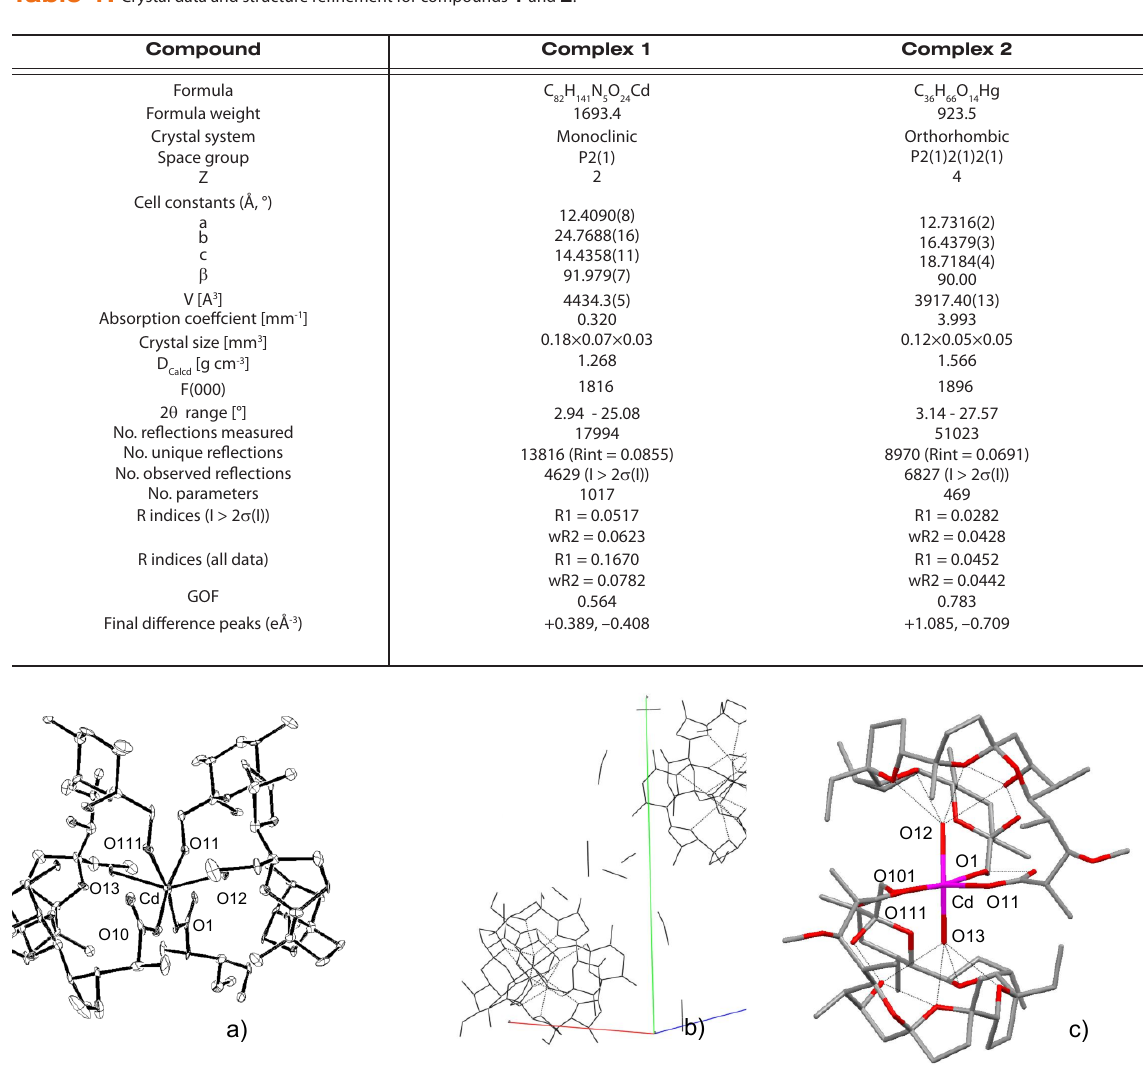
Figure 1. (a) ORTEP drawing of complex 1 at the 30% probability level (Protons and solvent molecules are omitted for clarity); (b) Crystal packing of 1 ; c) Intramolecular hydrogen bonding (dotted lines) observed in 1 . [25]. The M-O coordination bond distances depend on the size of the metal ion radii also and increase with increasing ion radii.